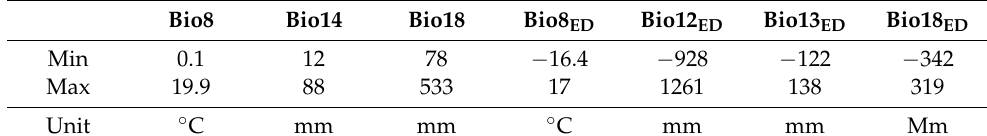
Table 2. Climatic boundary conditions of the neural network model based on minimal and maximal values from the original dataset used for development of the model.